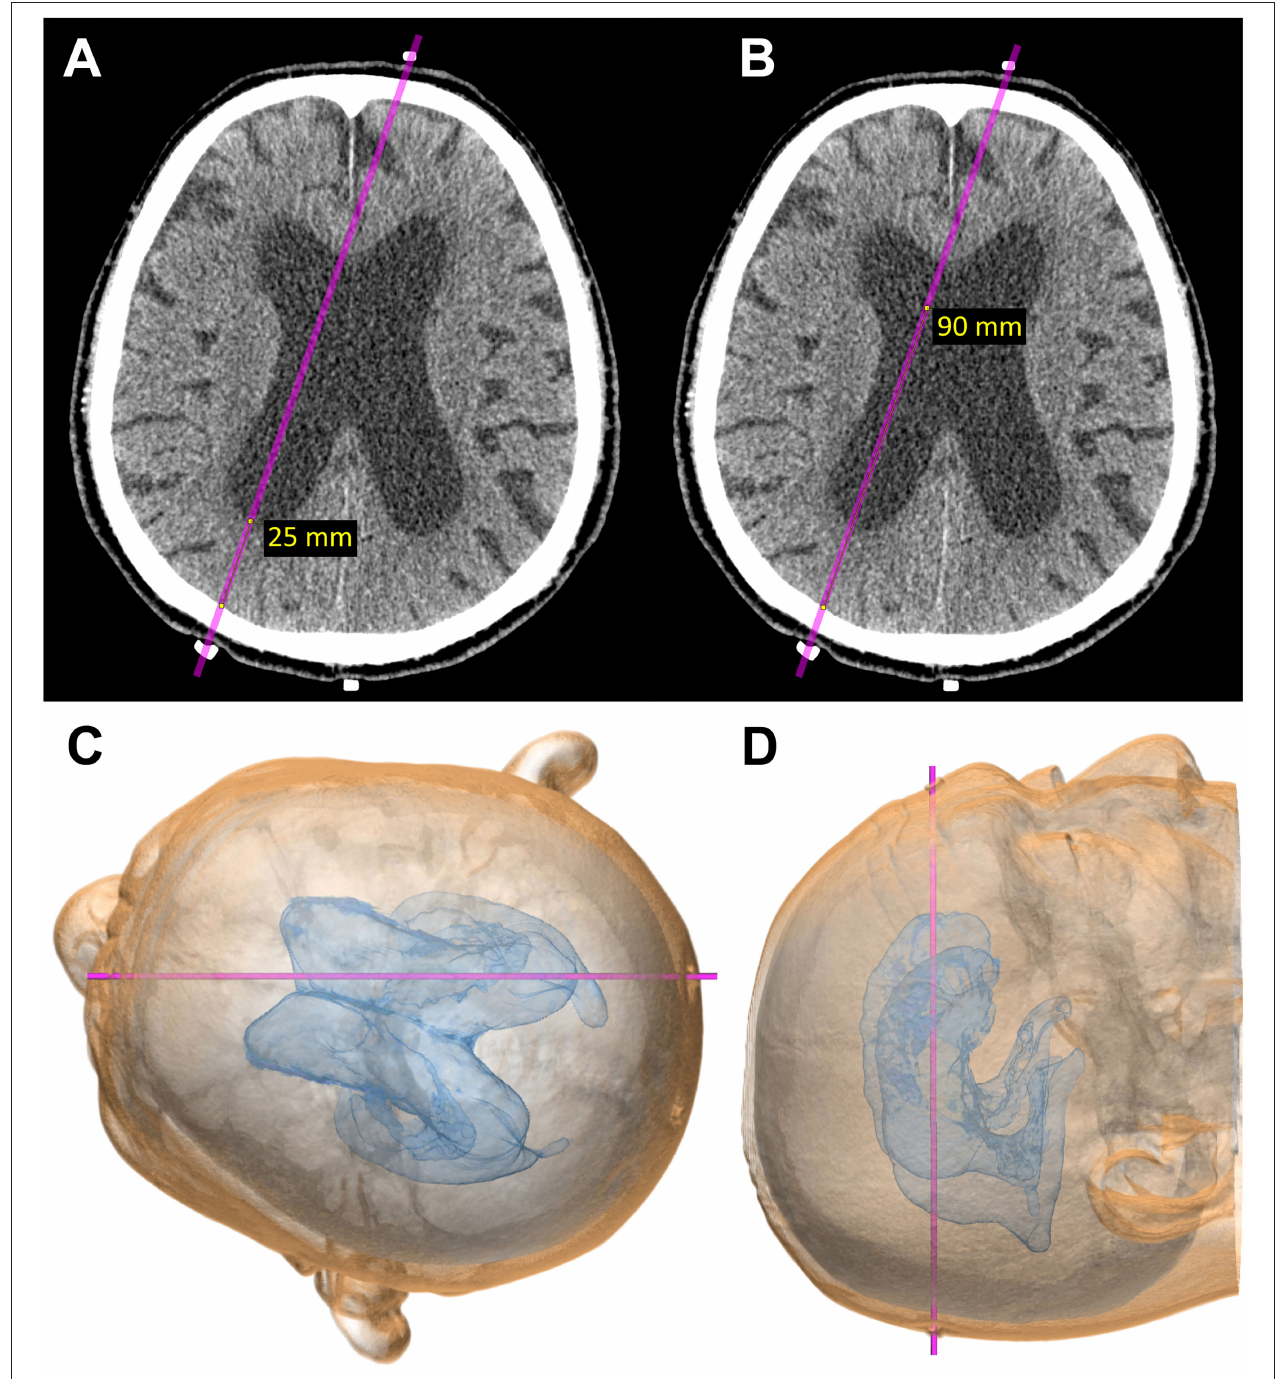
FIGURE 3 | Computational virtual simulation of ventricular puncture in parietooccipital approach from Frazier’s point. The depth from the brain surface to the entry point of the posterior horn of the lateral ventricle (A) and the length planned for ventricular catheter placement (B) were measured on the CT images. The virtual head position for surgery, setting the entry–target line parallel to the horizontal plane, was observed from the vertex angle (C) , and from above, perpendicular to the horizontal plane (D) .